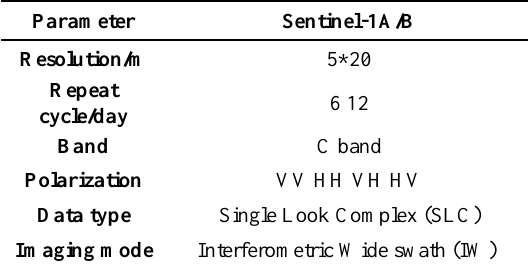
Table 1. Selected parameters of Sentinel satellite in this